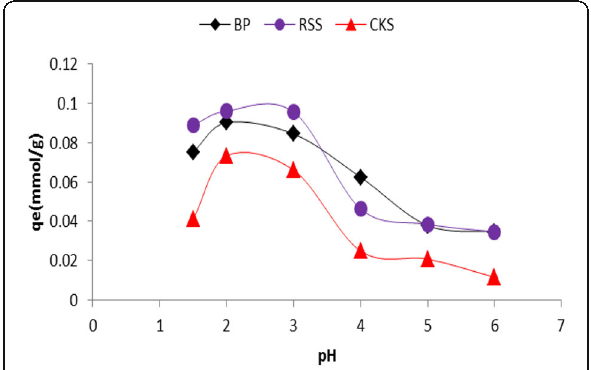
Fig. 2 Effect of pH on the adsorption of Cr(VI) by BP, RSS, and CKS (adsorption conditions: concentration of Cr(VI), 50 ppm; adsorbent dosage, 10 g/L; contact time, 1 h; temperature, 25 ± 1 °C; λ = 540